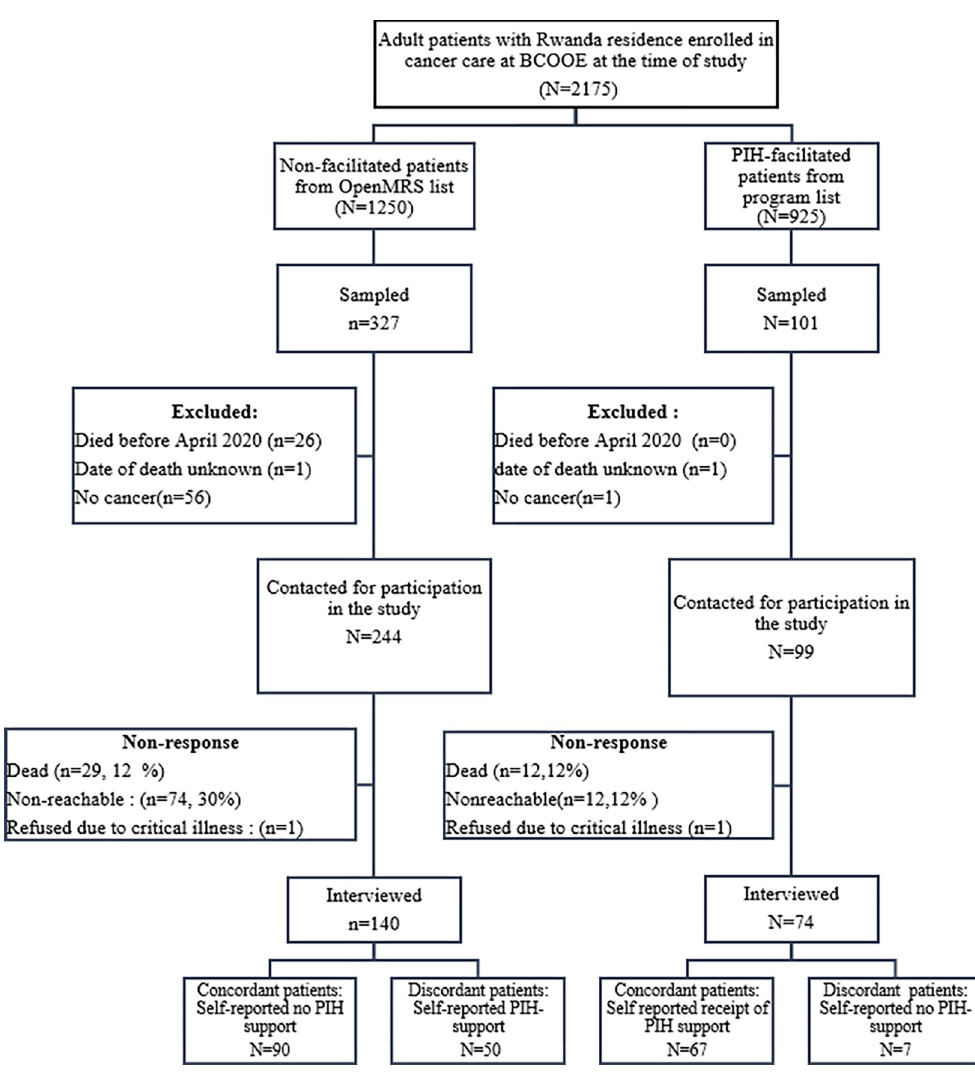
Fig 1. Flowchart of study